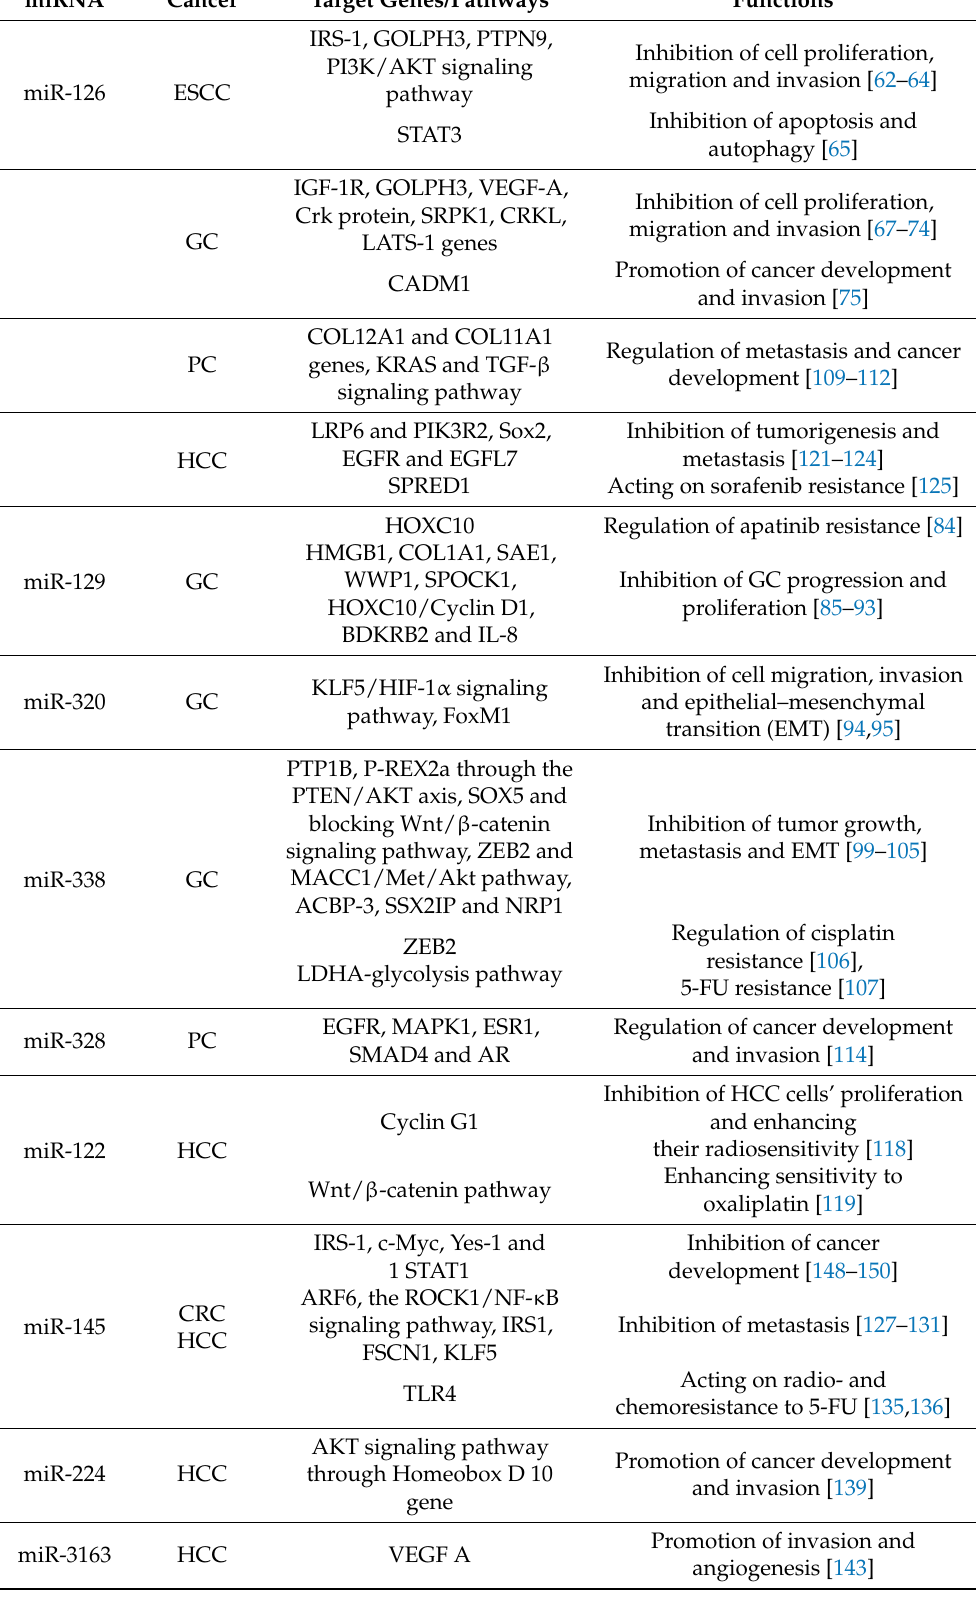
Table 2. The role of selected miRs and their targets in GI cancers. Own elaboration. miRNA